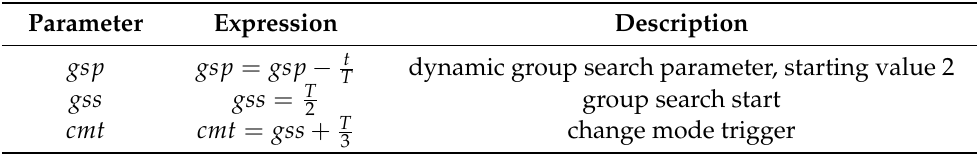
Table 1. Specific GSFA parameters’